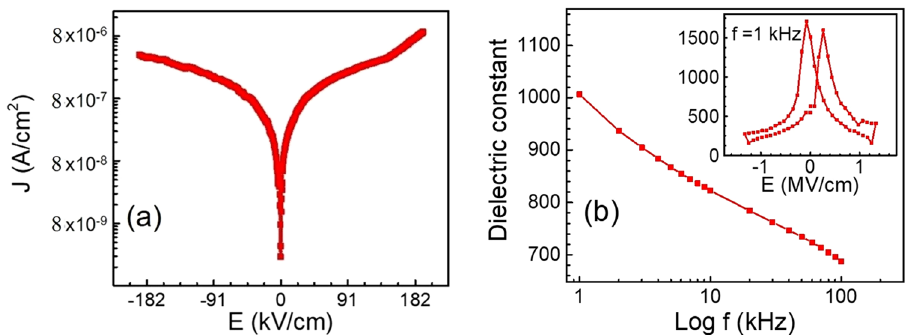
Figure 5. Variation of ( a ) leakage current density with electric field (J–E) curves and ( b ) dielectric constant with frequency and electric field at 1 kHz (inset) of BZT/BCT